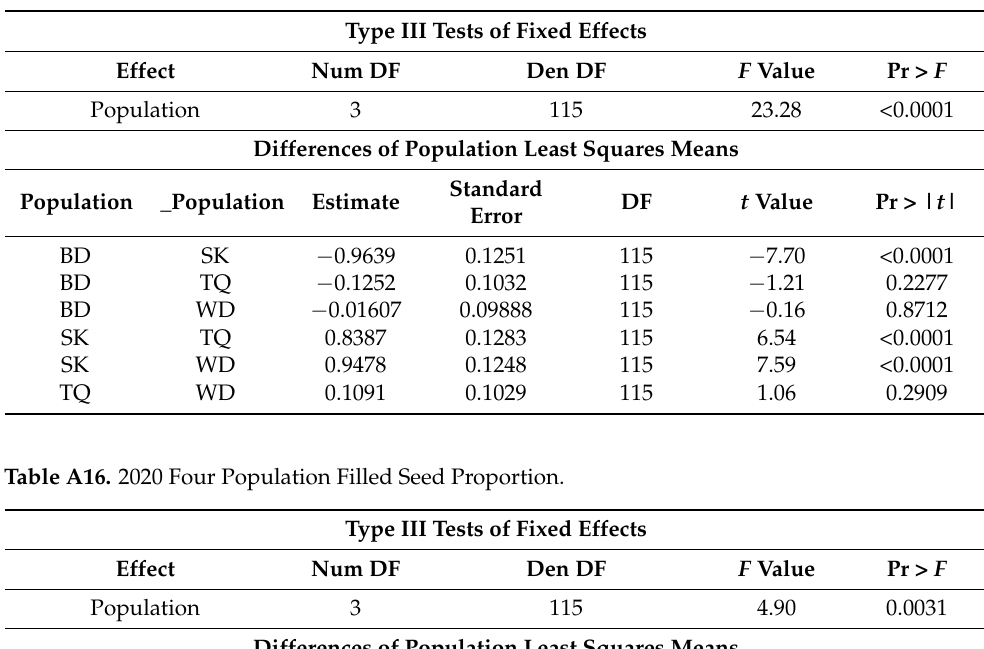
Table A15. 2020 Four Population Fertilization Success.